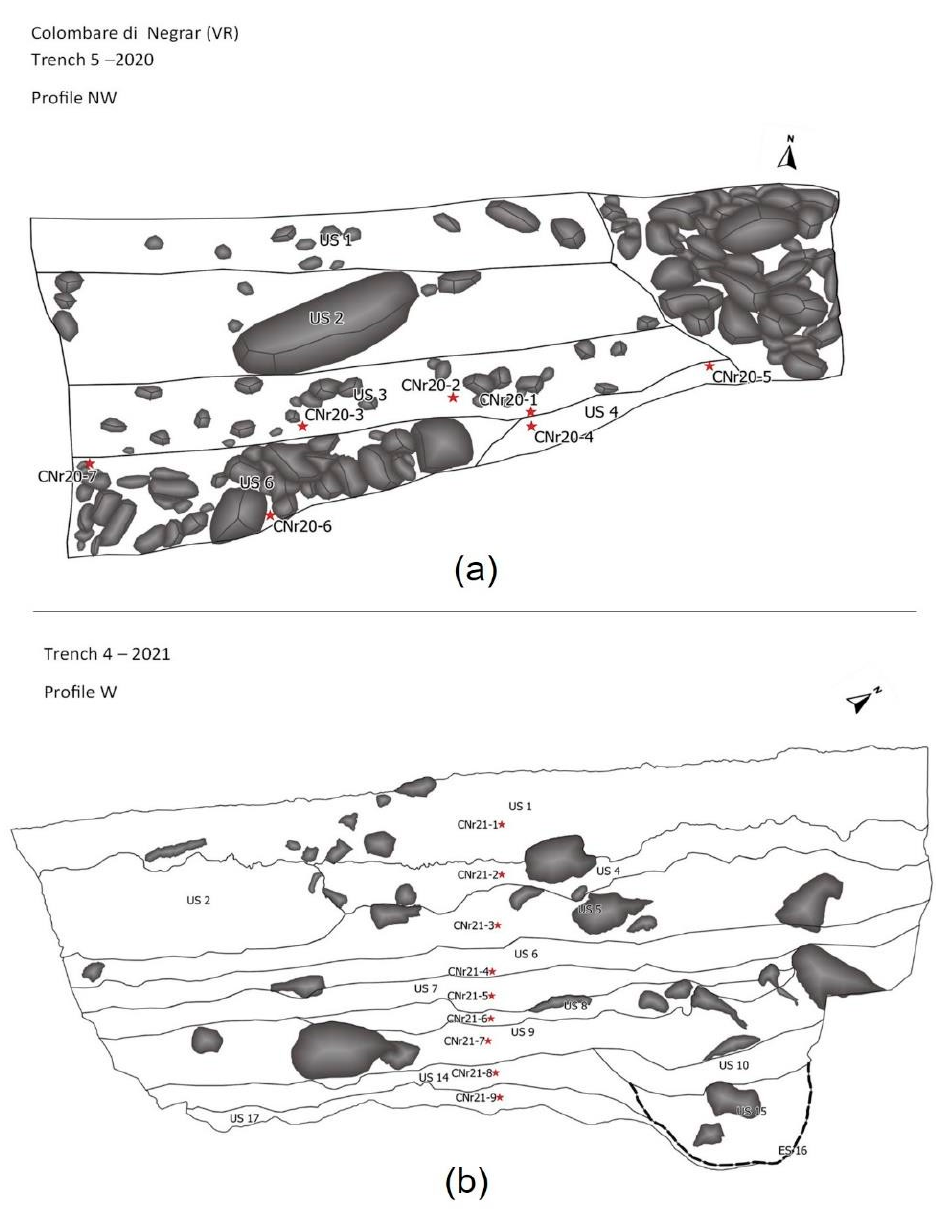
Figure 2. Colombare di Negrar: ( a ) Stratigraphy and pollen samples taken from Trench 5; ( b ) Stratigraphy and pollen samples taken from Trench 4.